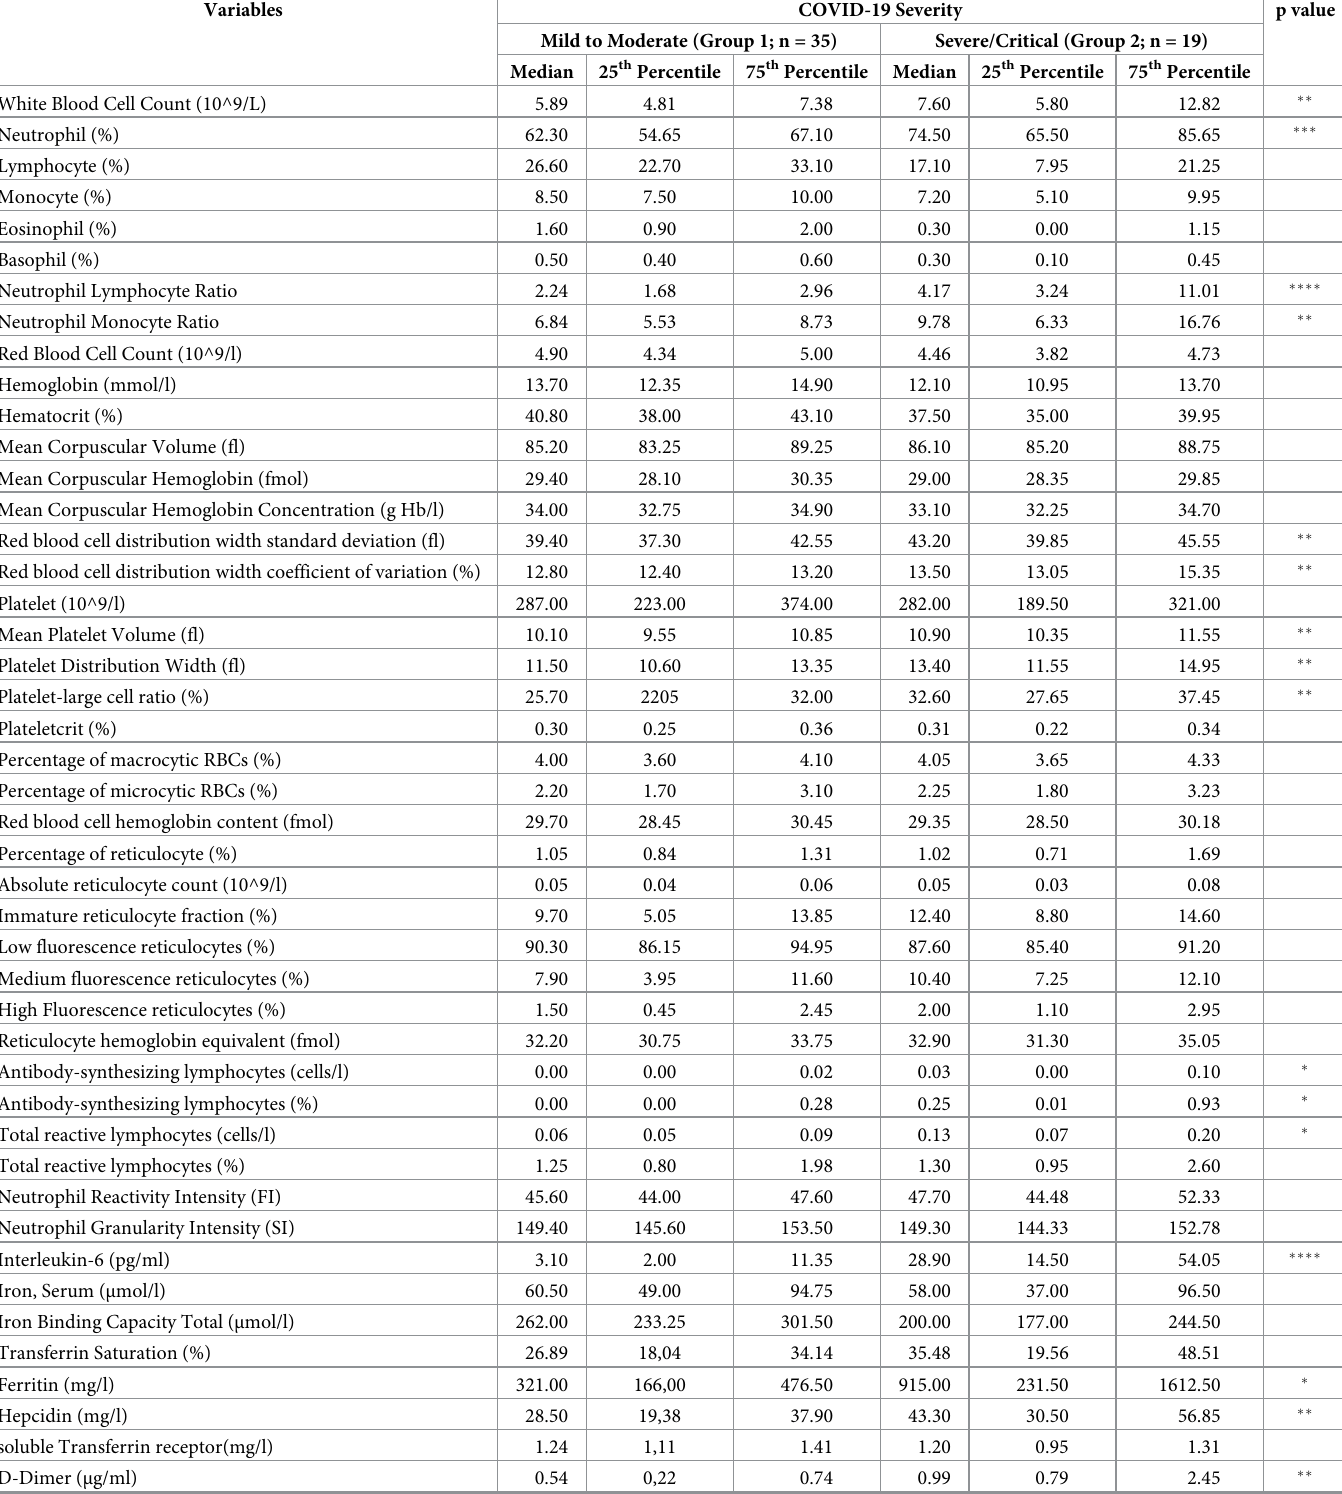
Table 4. Complete blood count and other hematological analysis based on COVID-19 severity (5–15 days).